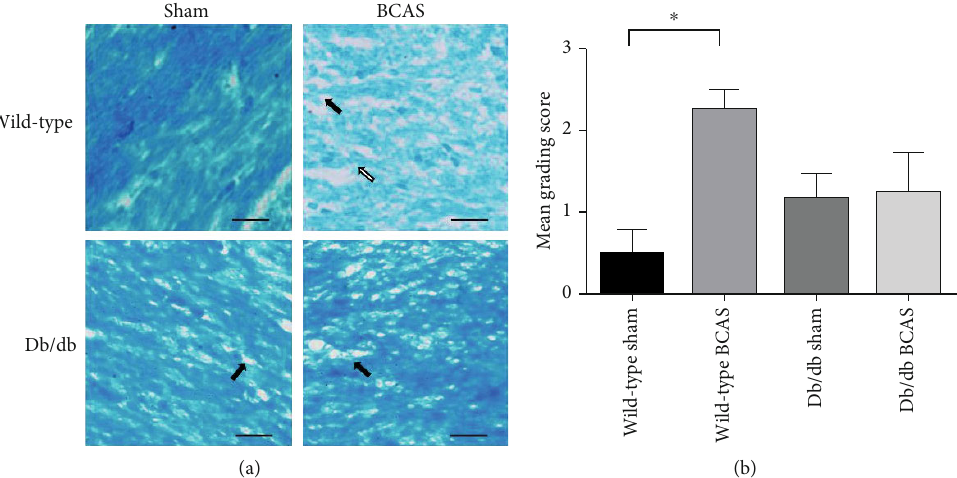
Figure 3: White matter lesions (WMLs) in wild-type and db/db mice with sham or BCAS operation for four weeks. (a) WMLs were evaluated using Klüver – Barrera (KB) staining. White matter vacuoles were shown by the black arrows, and the disappearance of myelinated fi bers was shown by the white arrow. (b) Histogram showing the mean grading scores of WMLs. N = 4 − 5 , scale bar = 20 μ m , and ∗ p < 0 : 05